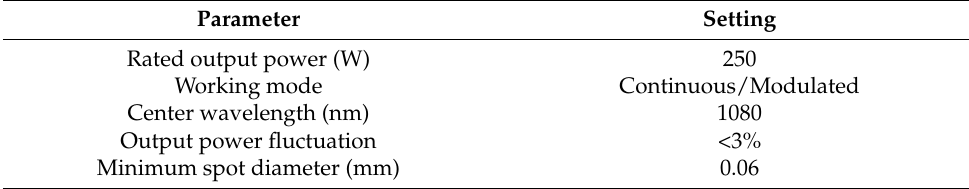
Figure 2. The L-PBF experimental facility, which consisted of a host, a laser system, a cooling system, a control system, and a gas protection system. Table 1. Primary working parameters of the laser [28].